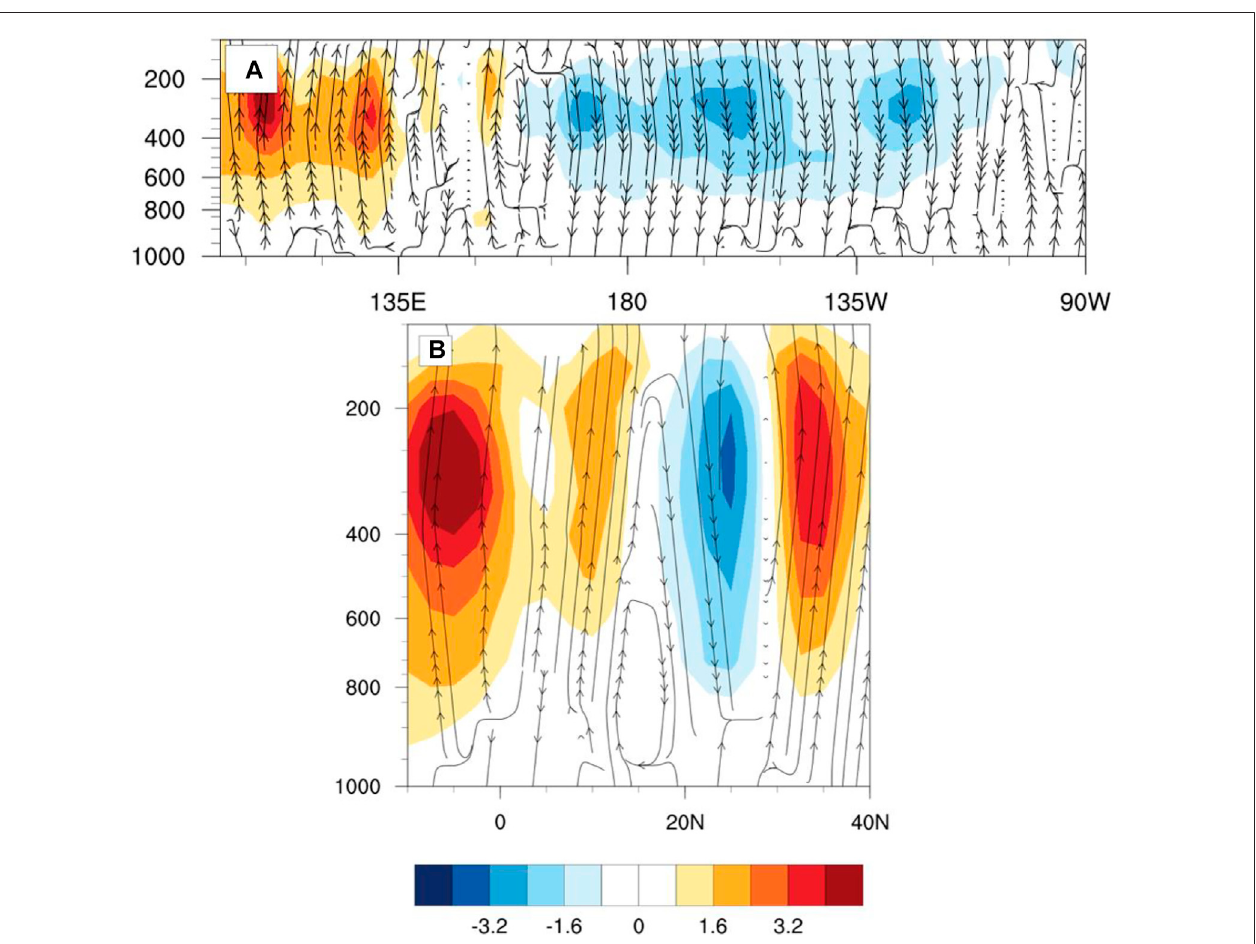
FIGURE6| Differences in (A) Walkercirculation (10 ° S-10 ° Naveraged) and (B) Hadley circulation (100 ° E – 120 ° Eaveraged) betweenthe composites ofpositiveand negativeyearsinP1[shadedareasindicatedifferencesinverticalvelocity(unit:10 − 4 ms − 1 )betweenthecompositesofpositiveandnegativeyears.Onlyvaluessigni fi cant at/above the 95% con fi dence level by Student ’ s t test are